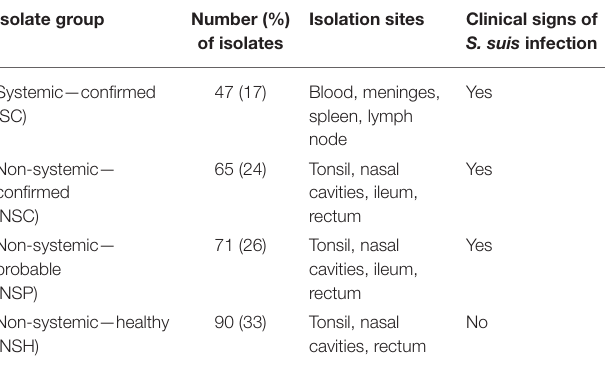
TABLE 1 | Distribution of 273 isolates recovered from sick and healthy pigs into isolate groups. Isolate